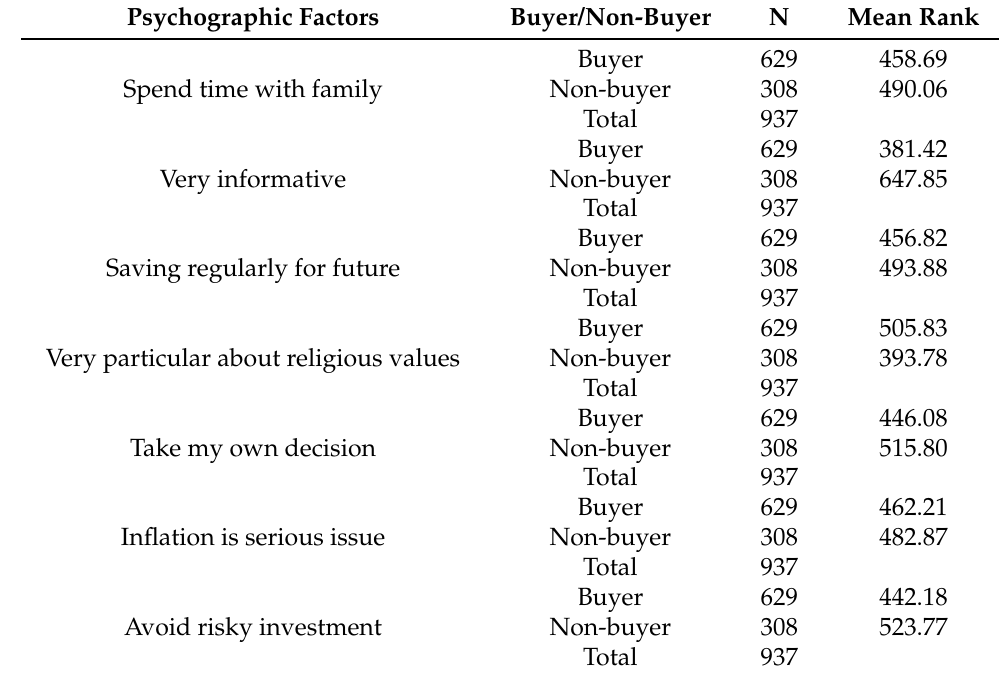
Table 5. Mean ranks of buyers and non-buyers against psychographic